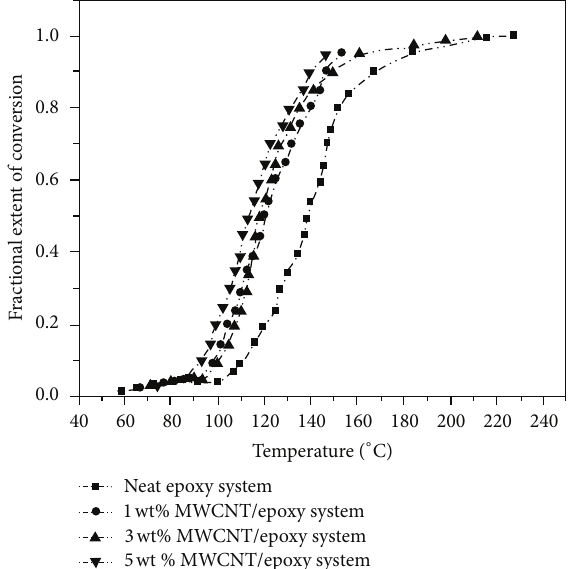
Scheme 5: Mechanism of curing epoxy resins with anhydride hardeners.